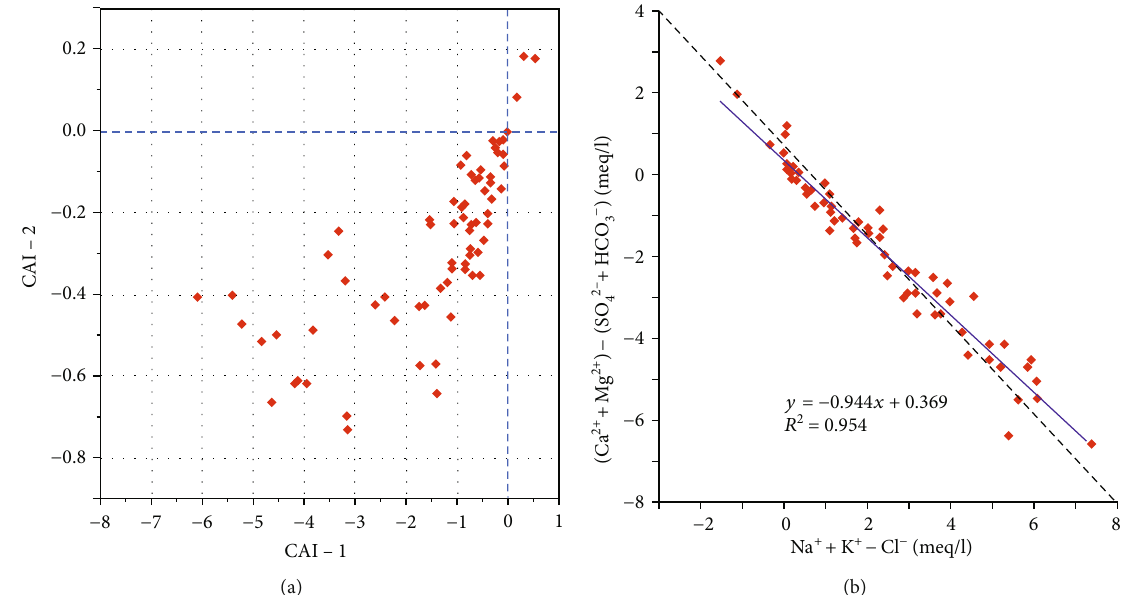
Figure 3: Plots showing (a) CAI-1 versus CAI-2 and (b) (Ca 2+ +Mg 2+ ) – (HCO 3- + SO 42- ) versus (Na + +K + )-Cl.